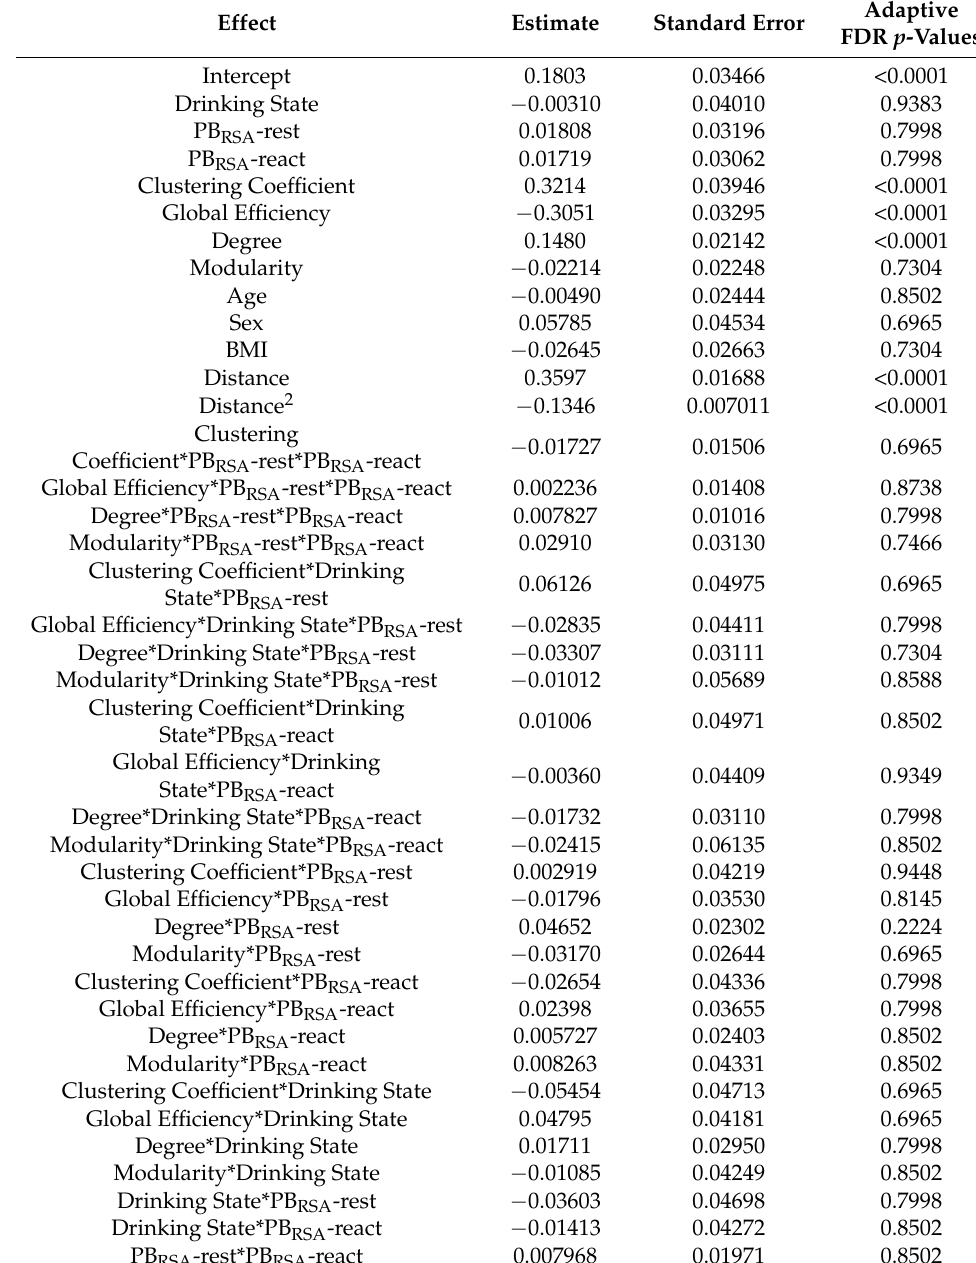
Table S3. Full mixed-effects model